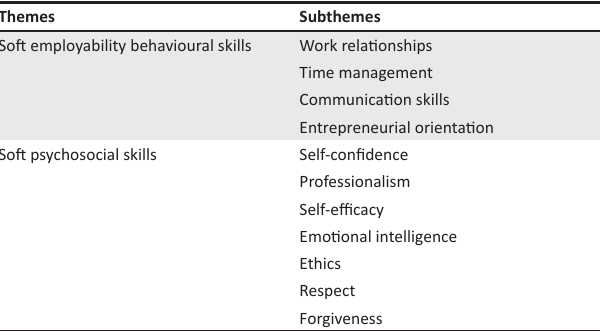
TABLE 1: Themes and subthemes.